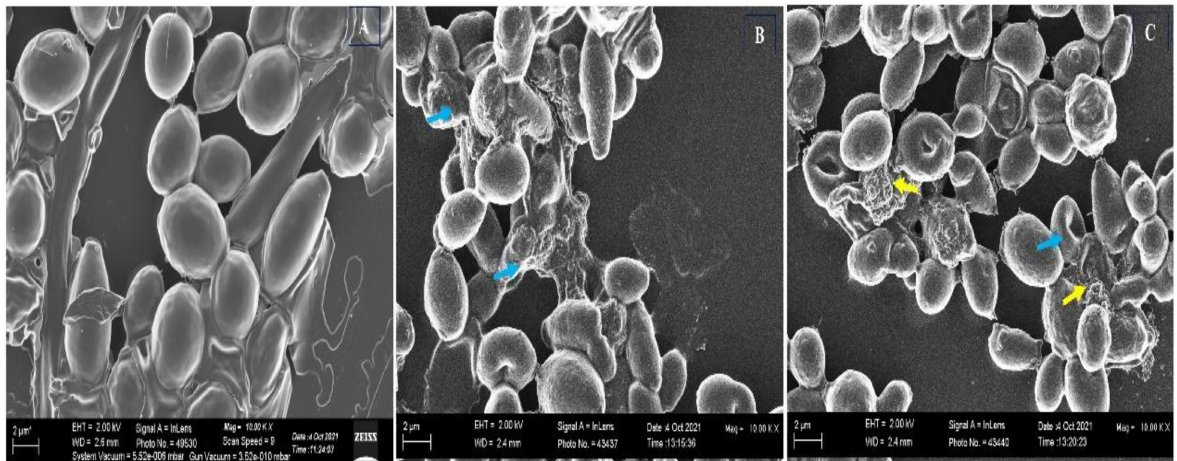
Figure 8. SEM images of FLZ-resistant C. albicans 5112. ( A ) Untreated control; yeast cells exposed to Ag-Ni NPs at different contractions: ( B ) 0.5 × MIC (0.78 µ g/mL) and ( C ) MIC (1.56 µ g/mL). Blue arrows show wrinkles, rupture, and distortion of C. albicans surfaces, whereas yellow arrows show discharge of intracellular material.